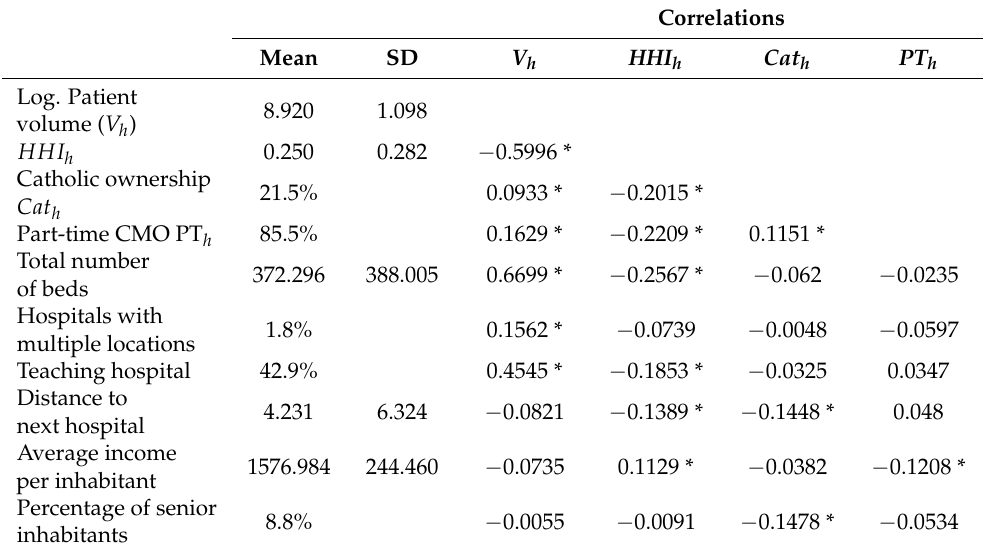
Table 1. Descriptive statistics and